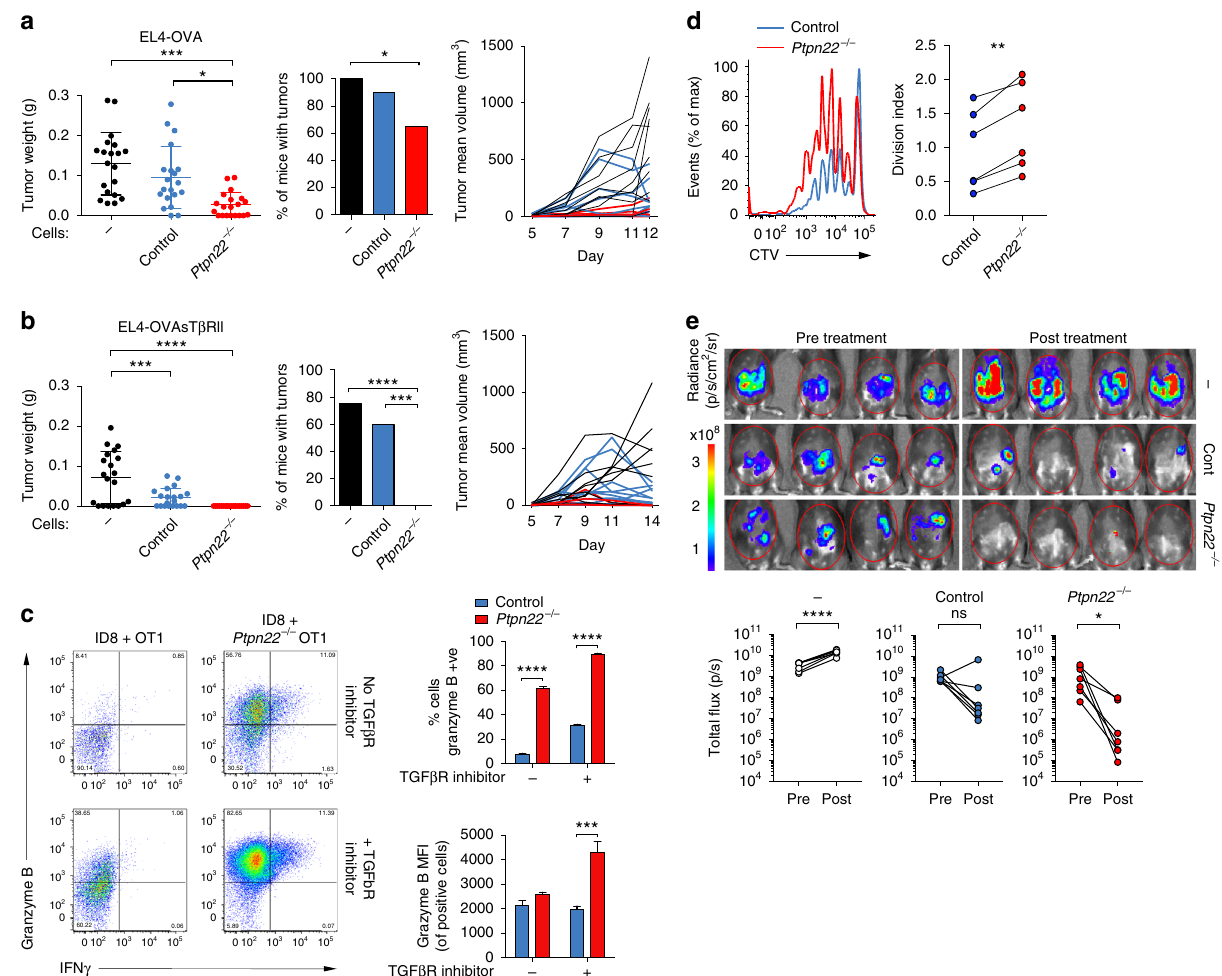
Fig. 3 Loss of Ptpn22 improves the response of CD8 T cells to tumors. a , b B6 mice were injected s.c. with 1 × 10 6 EL4-OVA ( a ) or EL4-OVAsT β RII cells ( b ). Five days later, 5 × 10 4 control or Ptpn22 − / − OT-1 cells were injected i.v. Tumor weight (left panel) and tumor incidence (middle panel) is shown (d12 for EL4-OVA, d14 for EL4-OVAsT β RII from two pooled experiments, n = 20/group). Right panel shows mean tumor volume of individual mice, which received no exogenous T cells (black lines), control OT-1 T cells (blue lines), or Ptpn22 − / − OT-1 T cells (red lines) until termination of the experiment on d12 ( a ) or d14 ( b ) from one experiment ( n = 10/group). c Control and Ptpn22 − / − OT-1 cells were co-cultured with ID8 tumor cells ± ALK-5/TGFR1 inhibitor SB431542. After 2 days, Brefeldin A was added to cultures for 6 h and cells were stained for intracellular granzyme B and IFN γ analysis by fl ow cytometry. Representative dot plots and quanti fi cation (mean and s.d. of three replicates) are shown. a – c * p < 0.05, ** p < 0.01, *** p < 0.001, **** p < 0.0001 as determined using two-way ANOVA with Tukey ’ s post test for multiple comparisons and for incidence data *** p < 0.001 and **** p < 0.0001 as determined by χ 2 -test with Fisher ’ s exact post test adjusting the p value for number of comparisons. Data are representative of three separate experiments. d Groups ( n = 6) of CD45.1/2 B6 mice were injected i.p. with 1 × 10 7 ID8 cells, followed 28 days later with an i.p. injection of a mix of CTV-labeled control CD45.1 + OT-1 and Ptpn22 − / − CD45.2 + OT-1 cells (1 × 10 6 of each). Peritoneal lavage was harvested 3 days later and assessed for OT-1 T cell proliferation by fl ow cytometry. Division index was calculated using Flowjo software. ** P < 0.01 as determined by Student ’ s paired t test. Data are representative of two experiments. e Groups ( n = 7) of B6 mice were injected i.p. with 5 × 10 6 ID8-T4- fl uc2 cells and assessed for tumor establishment on d11 (pre treatment) by bioluminescence imaging. On d12, groups of mice received either no cells, 10 × 10 6 control OT-1 CTLs, or Ptpn22 − / − OT-1 CTLs i.p. All mice were assessed for tumor growth by bioluminescence imaging on d26 (14 d post treatment). Example images of n = 4 mice/group are shown d11 and d26 (pre/post treatment). Graphs show bioluminescence signal intensity of all mice on d11 and d26 (pre/post treatment). * p < 0.05, **** p < 0.0001, as determined by Student ’ s paired t test. Data are representative of two